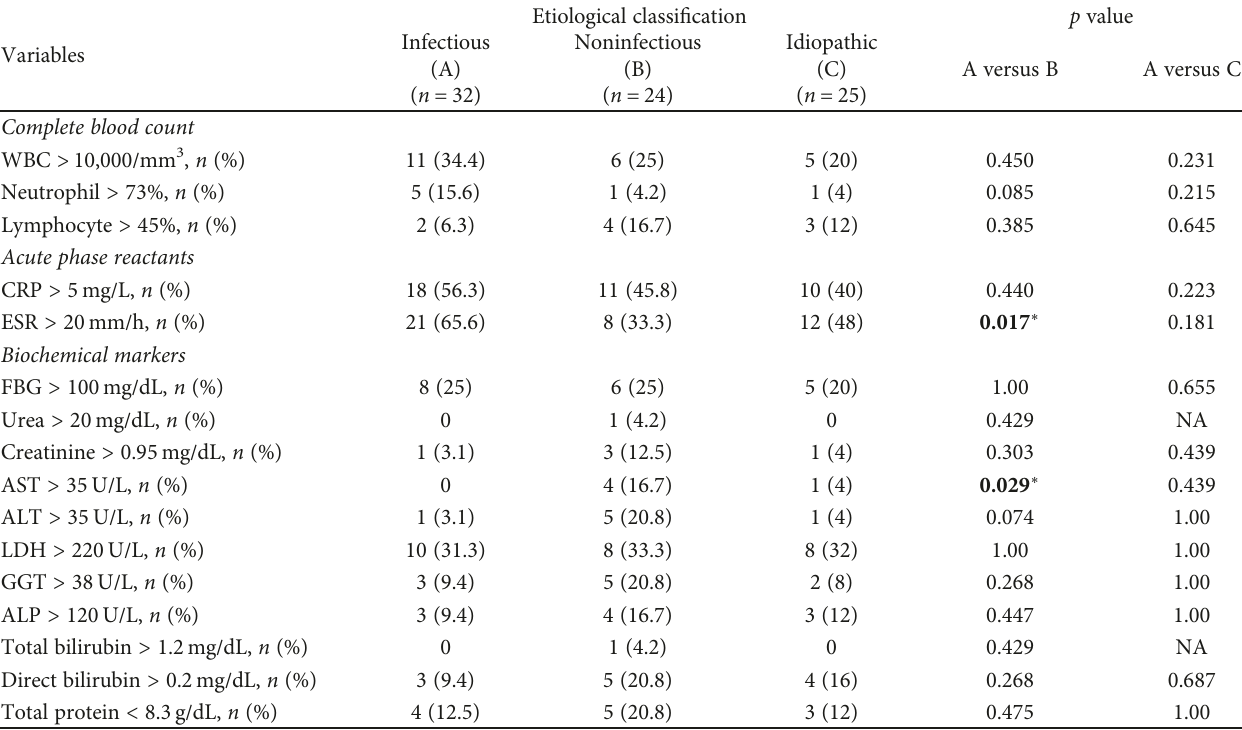
Table 5: Laboratory characteristics of erythema nodosum patients according to the etiological classi fi cation ( n = 81 ).